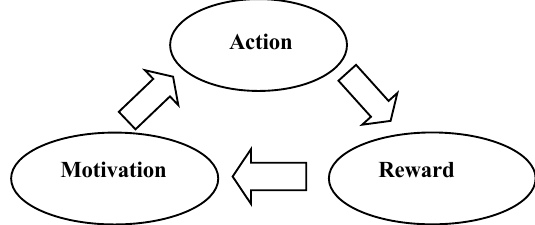
Fig.2. Authors’ elaboration. Gamification